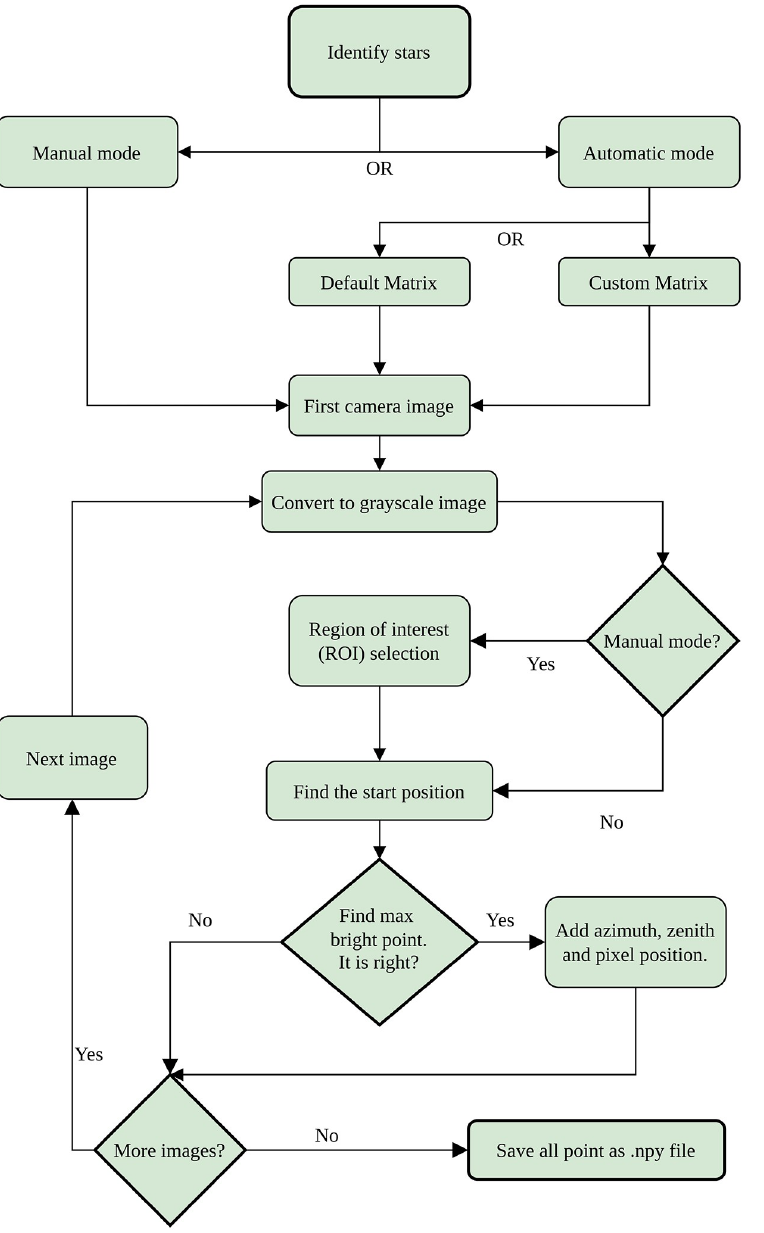
Fig 1. Flowchart for star selection modes. The rhombuses represent decisions made by the user. After obtaining the coordinates of the stars, ORION only needs to identify the position of the center of the chosen star in each sky image. In manual mode ORION assumes that the cen- ter of the chosen star is located in the brightest pixel of the ROI (chosen manually) and it stores the x and y position of that pixel. In automatic mode, ORION uses the initial matrices (previ- ously selected) to select the position of the ROI and then, to find automatically the brightest pixel inside. If the accuracy of the initial calibration matrices is admissible, the actual image of